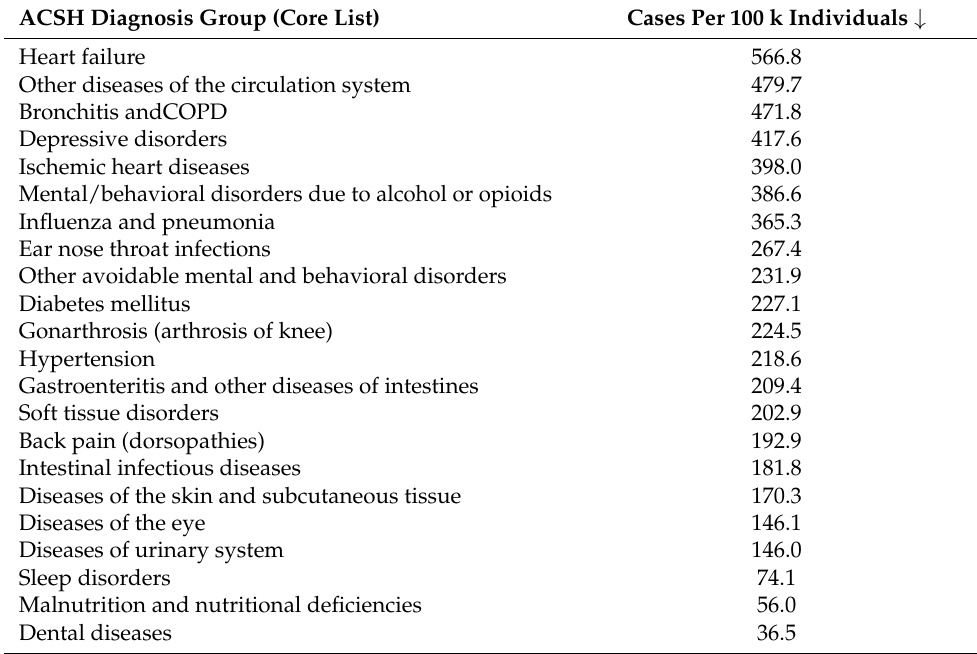
Table 2. Descriptive analytics of the ACSH cases per 100,000 individuals in